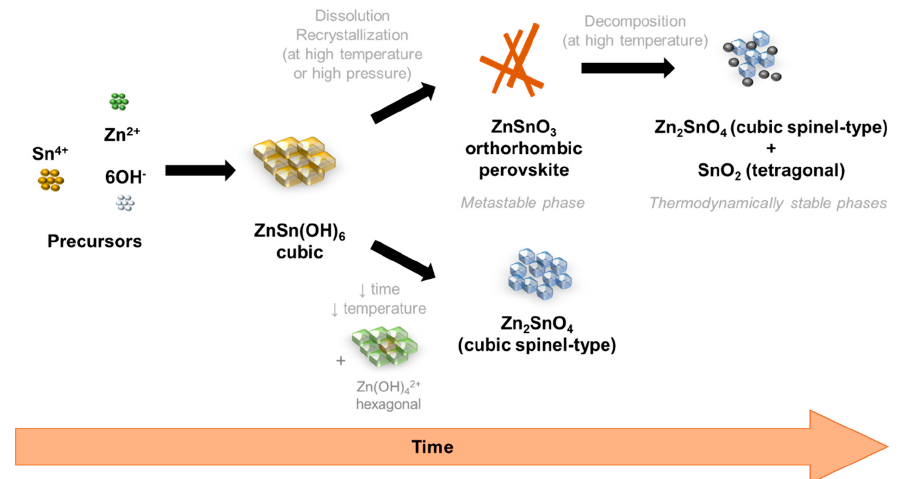
Figure 7. Schematic representation of the phase transformations on the hydrothermal synthesis of zinc-tin oxide (ZTO) nanostructures, depending on the energy available in the reaction and the time of synthesis.